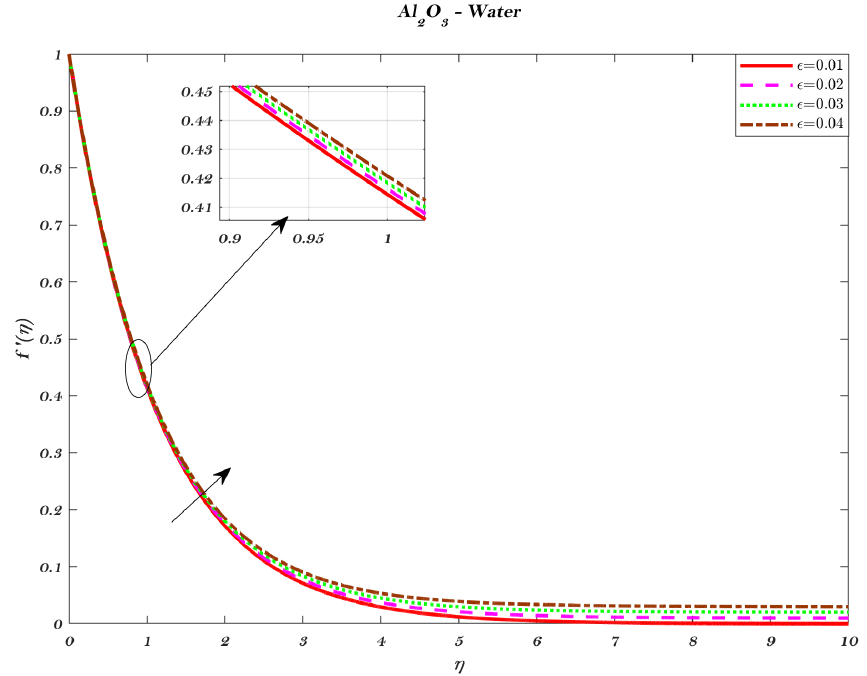
Figure 14. The effect of the stagnation parameter (cid:101) on the velocity profile with fix parameters ϕ = 3%, P r = 6.96 and ˘ a = 0.01.